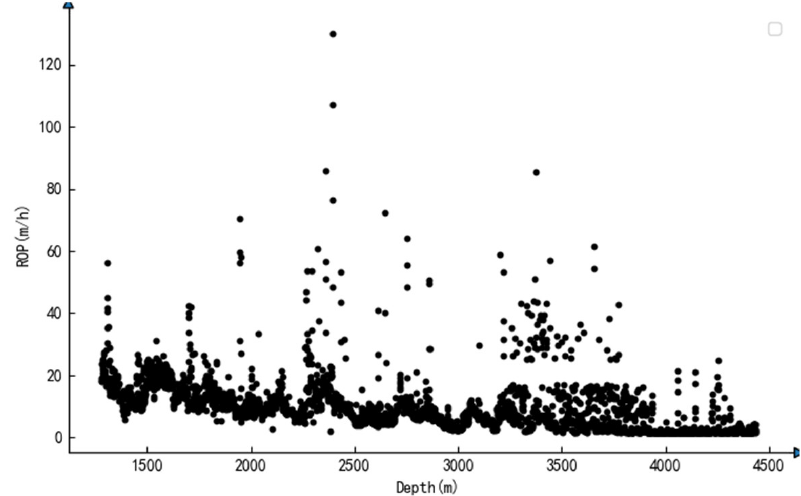
Figure 7. ROP data collected from the oil